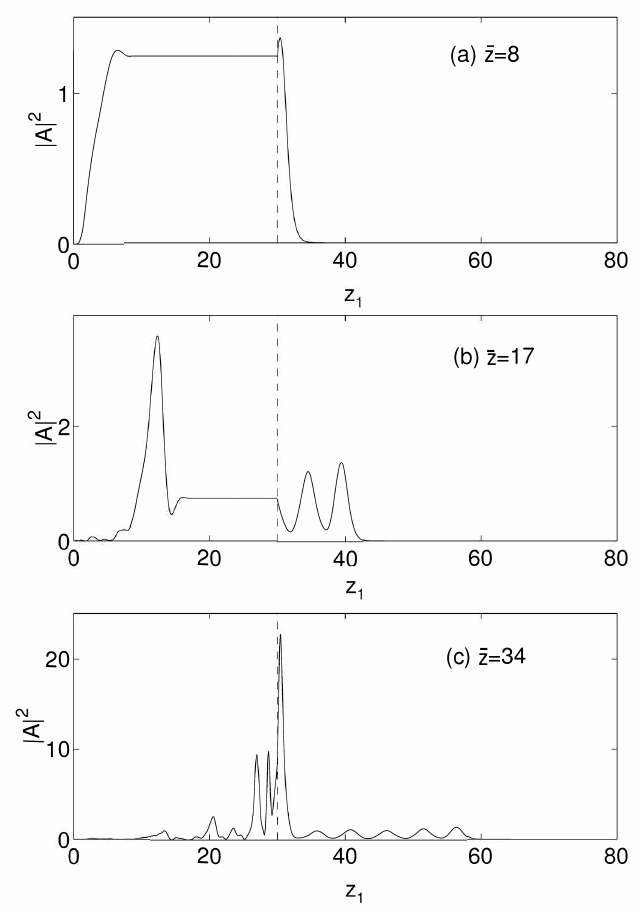
Figure 5. Strong superradiance, with l b = 30 l c , δ = 0 and different values of ¯ z : ( a ) ¯ z = 8; ( b ) ¯ z = 17; ( c ) ¯ z =